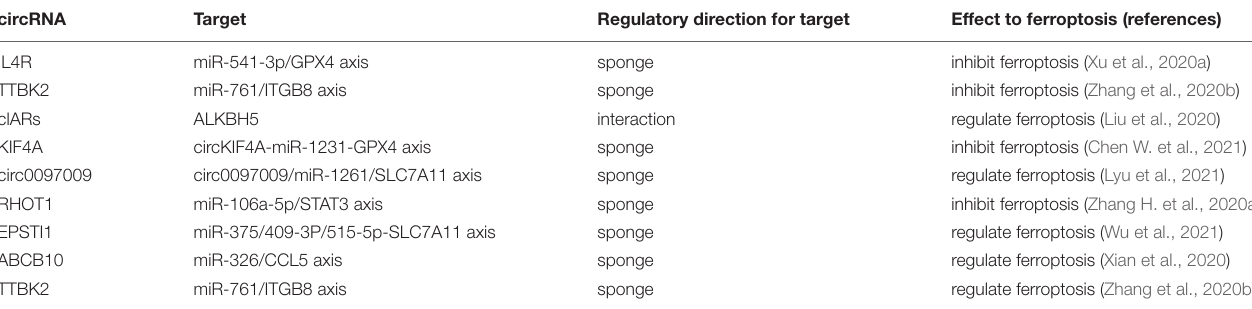
TABLE 3 | circRNAs modulate the induction of ferroptosis in cancer.